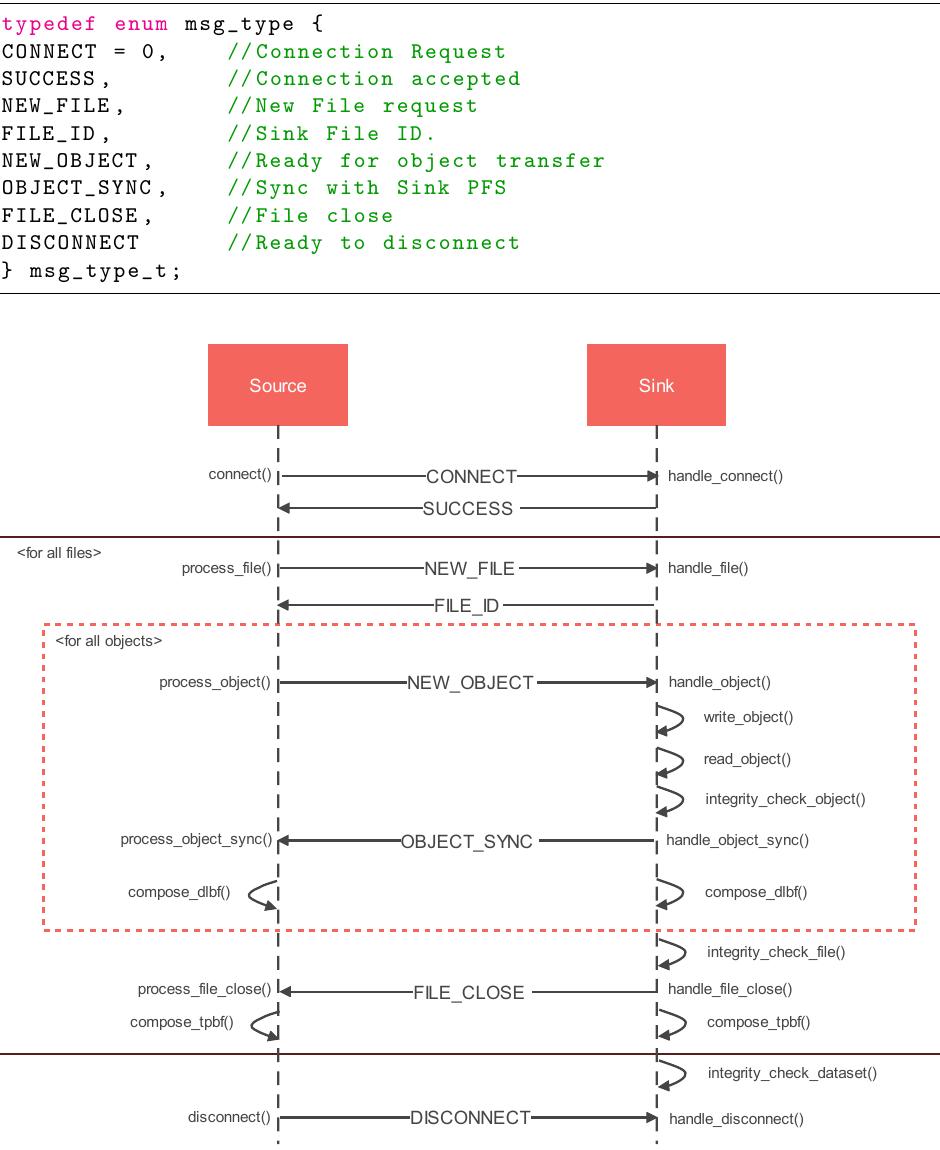
Figure 5. Communication sequence of two-phase Bloom-filter-based end-to-end data integrity